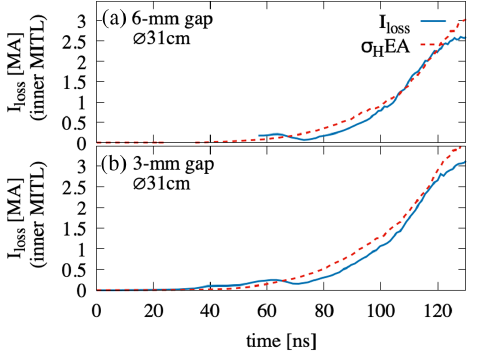
¼ I − I ) compared to an loss in load